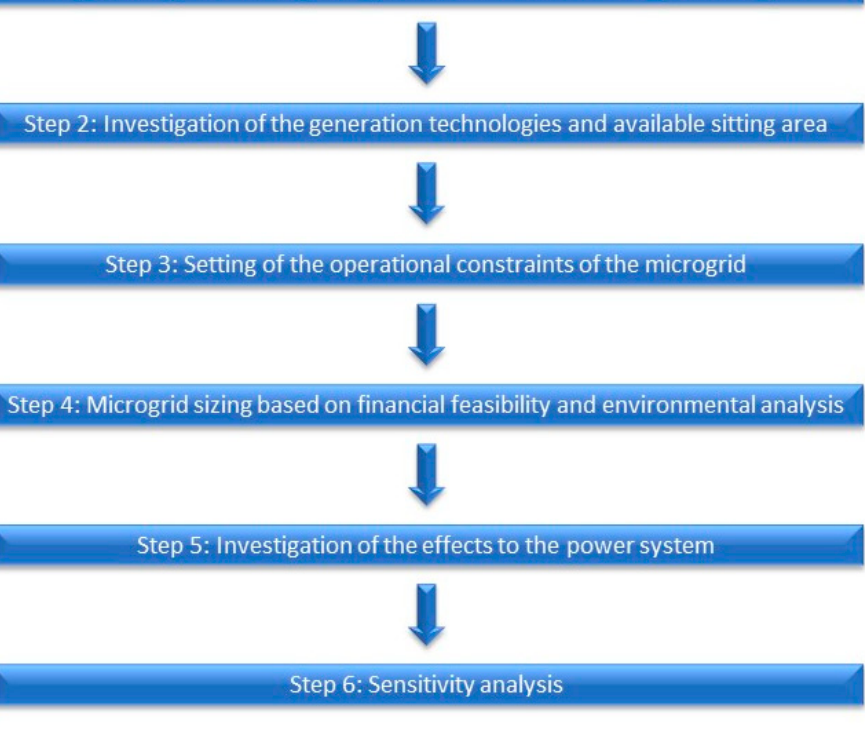
Figure 1. Hourly time series for the load demand of a smart campus microgrid.